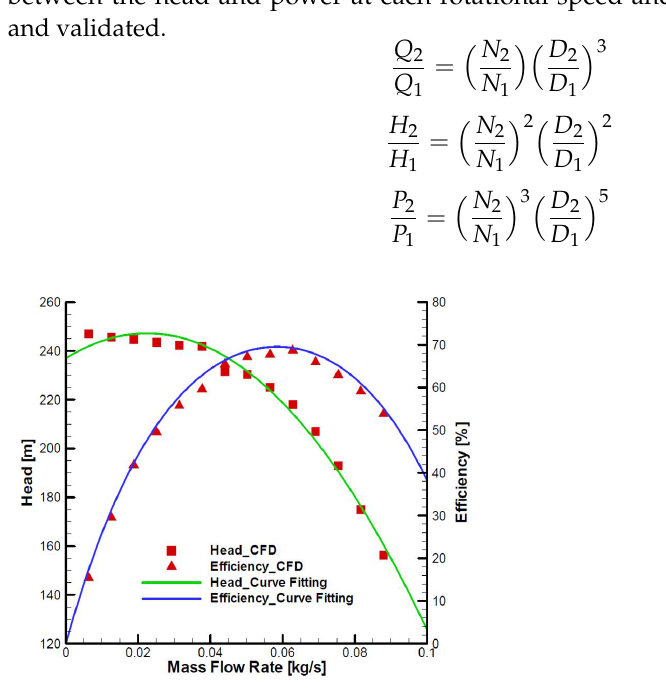
Figure 11. Pump characteristic curve.